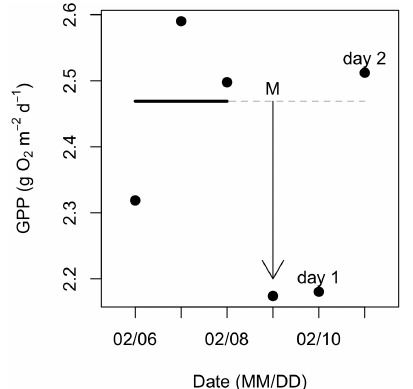
Figure 3. Example calculations of metabolic resistance (magnitude of departure; M ) and resilience (recovery interval; RI). Daily gross primary production (GPP) was estimated for the 3d before, 1d during, and 2d following an isolated flow event that occurred on 9 February 2017. The solid (prior to the flow event) and dashed (during and after the flow event) horizontal line represents the mean of GPP estimates from 3d prior to the flow event. In this case, GPP declined with higher flow, and the magnitude of departure ( M with arrow) is the difference between mean prior GPP (dashed line) and GPP during the event. After this flow event, GPP recovered to its prior mean on day